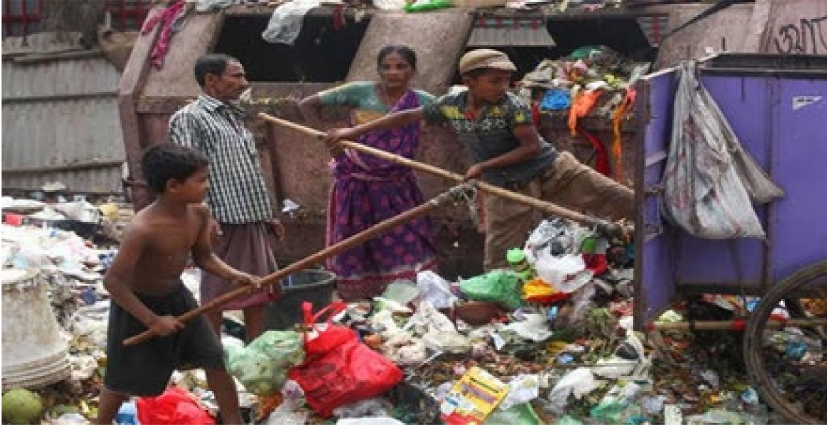
Figure 2. Plastic traveling from domestic disposal to a local dumping station (Photo: